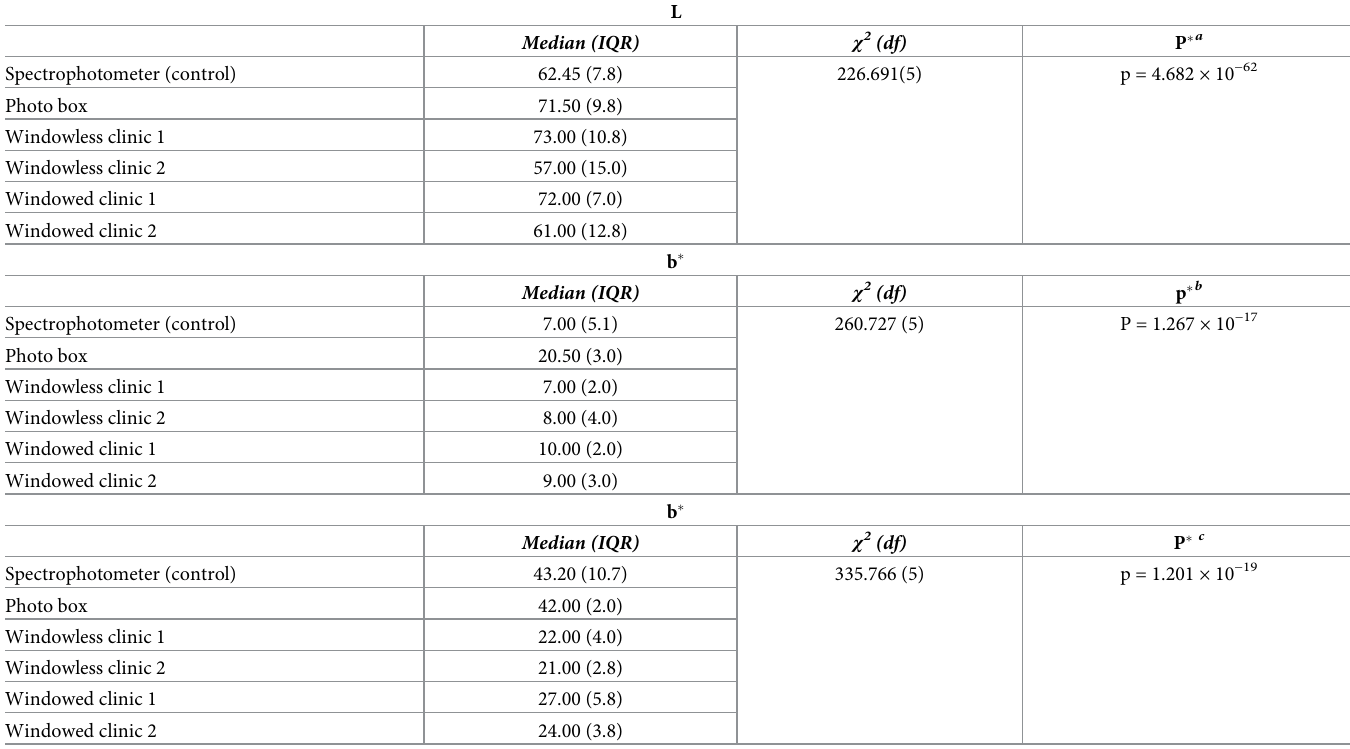
Table 1. Comparison of L, a � and b � values for images without any white balance correction (raw